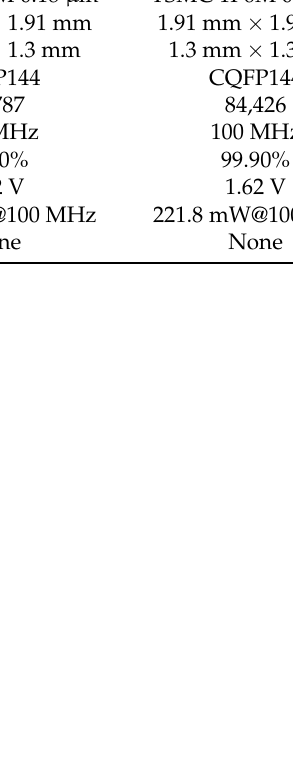
Figure 5. By TSMC 0.18 μm process, the physical circuit was produced with 144 pins. Table 1. Chip basic specifications technical.